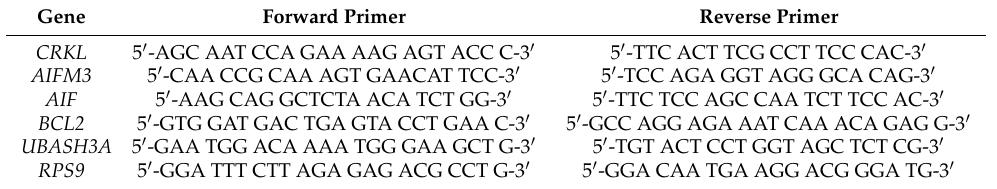
Table 1. Primers used in